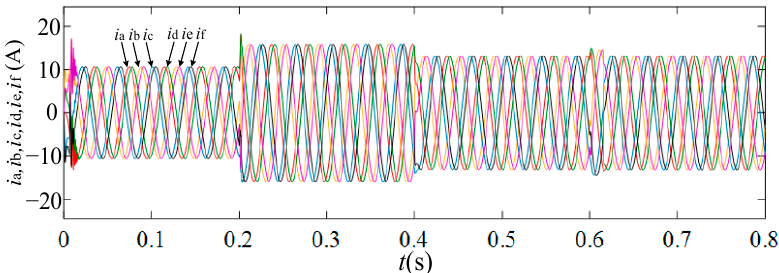
Figure 9. Current waveform of load and disturbance during normal operation.